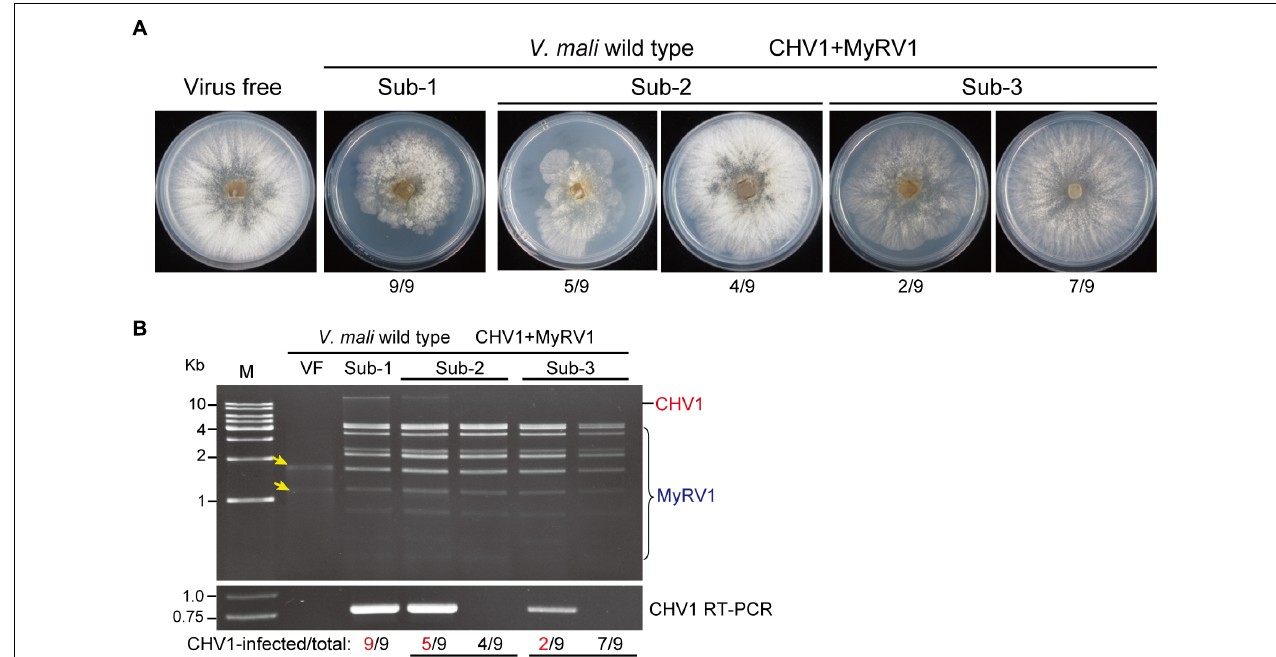
FIGURE 3 | The accumulation of CHV1 and MyRV1 in co-infected V. mali after subsequent subculturing. (A) The phenotypic growth on PDA medium of representative V. mali strains co-infected with CHV1 and MyRV1 in the first to third fungal subcultures (Sub-1 to Sub-3). The colonies were grown on PDA for 4 days and then photographed. The numbers below the images indicate the number of fungal colonies showing a similar phenotype as presented in the photo per total number of colonies shown. (B) Viral dsRNA and RT-PCR analyses of doubly infected V. mali strains described in (A) . The numbers below the lanes indicate the number of samples in which CHV1 was detected or undetected per total number of samples. Yellow-colored arrows mark the traces of ribosomal RNAs in virus-free (VF) sample incorporated during dsRNA